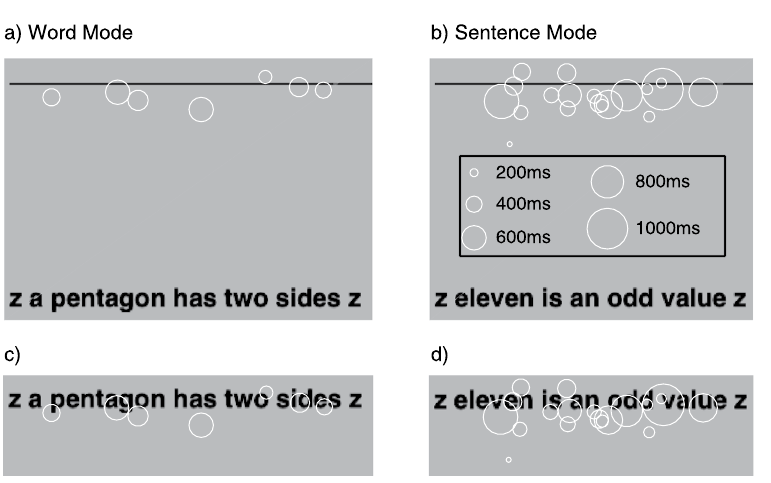
Figure 5. Fixation patterns for observer RJS, for both Word Mode (panels a, c) and Sentence Mode (panels b, d), reading 0.8 logMAR text. The top panels show the fixation line (solid horizontal line), the number of fixations (as white circles of varying diameter to indicate fixation length in ms) and the target sentence. The separation between the fixation line and the target sentence is representative of the viewing display used. Note that, for comparison, the whole sentence is shown in Word Mode. In panels (c) and (d) the text has been raised vertically onto the centre of the fixation line, and the fixation line